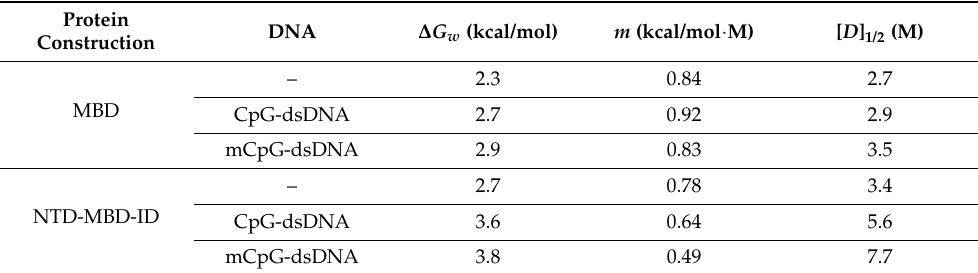
Figure 4 . Chemical unfolding curves for MBD (circles) and NTD-MBD-ID (squares). The fluores- cence intensity of the protein at 340nm was represented as a function of the urea concentration: free protein (black), protein bound to unmethylated CpG-dsDNA (blue), and methylated mCpG- dsDNA (red). Table 4. Thermal unfolding parameters for MBD and NTD-MBD-ID at pH 7, estimated by analyzing the denaturant dependence of the fluorescence intensity at 340 nm.